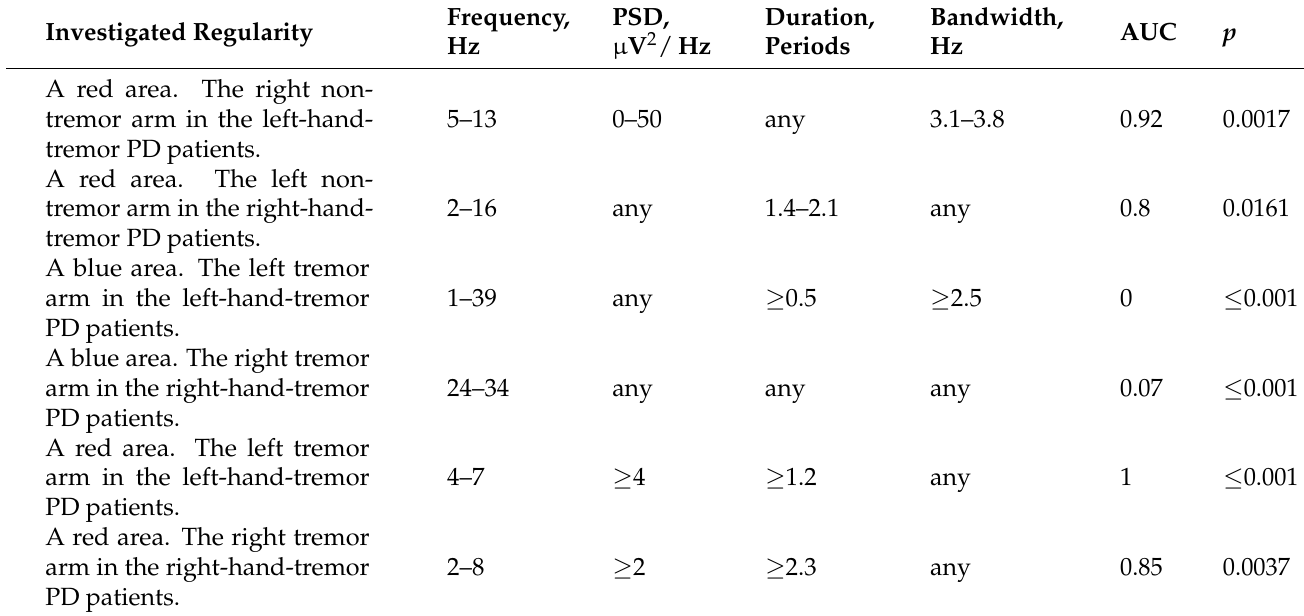
Table 2. The characteristics of the wave trains in the flexor